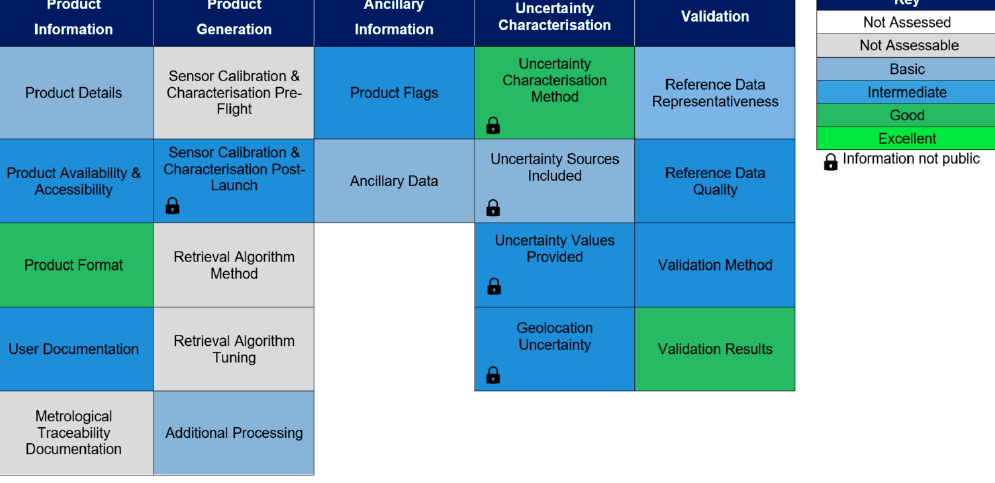
Figure 17. SkySat maturity matrix produced in EDAP activities.